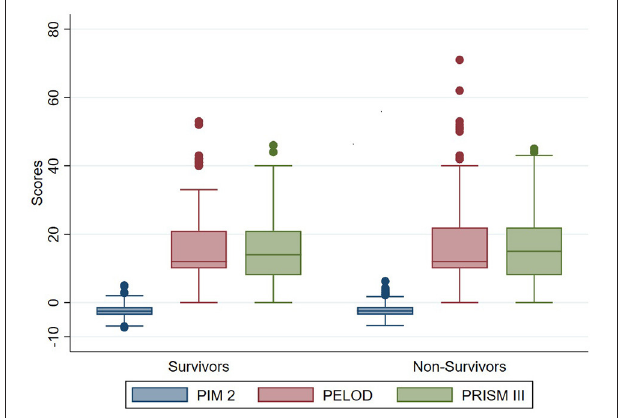
FIGURE 2 | Score distributions for survivors and